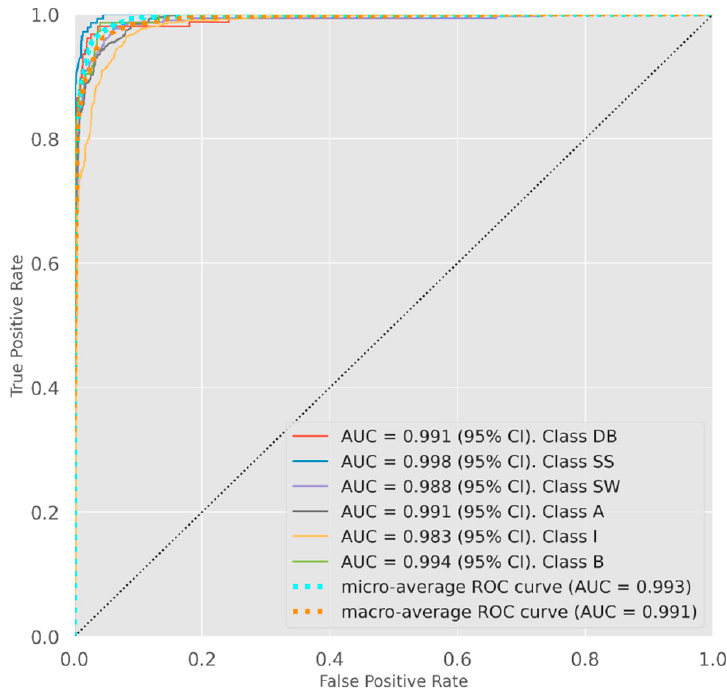
Figure 15. ROC curves for CNN classifier for six classes.